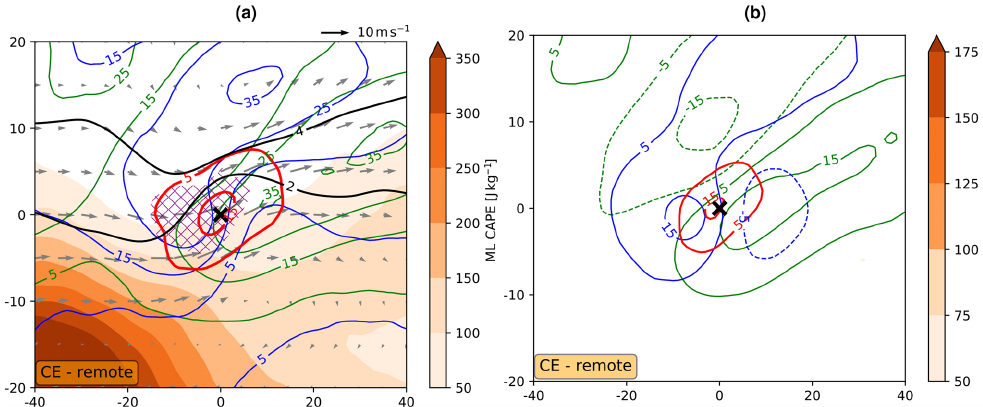
Figure 8. Composites centred around the position of maximum diabatic heating for the remote heating branch reaching upper-tropospheric anticyclones above central Europe. (a) Frequencies of extratropical cyclones (blue), blocks (green) and warm conveyor belts (red) starting from 5% in 10% increments. The orange shading shows the ML CAPE (in Jkg − 1 ) and the arrows the wind at 800hPa. Black contours indicate PV (2 and 4PVU contours) at 330K. The purple hatching marks the region where the stratiform precipitation exceeds the convective precipitation (only for areas with total precipitation ≥ 2mmd − 1 ). (b) Anomalies of cyclone (blue), blocking (green) and warm conveyor belt (red)